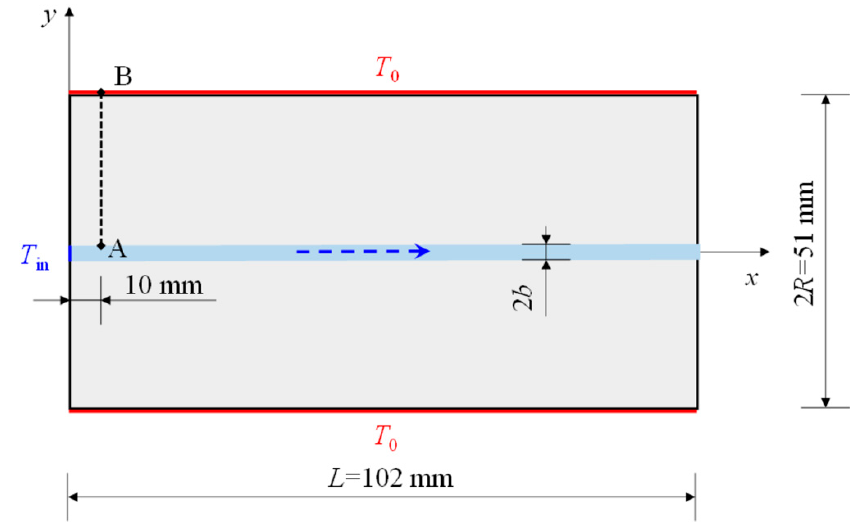
Figure 1. Model of heat transfer in single rock fracture.